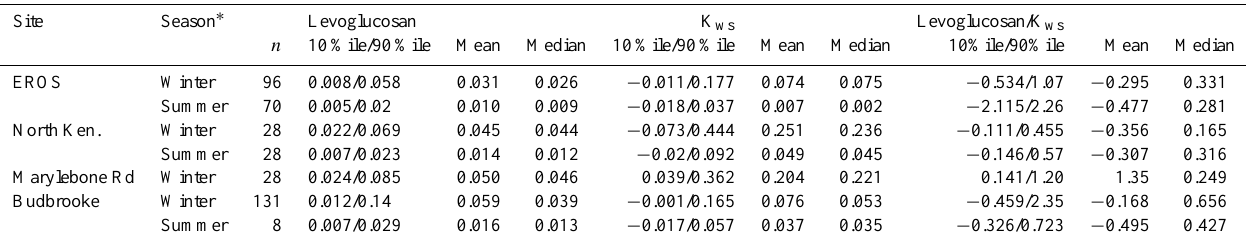
Table 1. Summary of levoglucosan and potassium (K ws ) data (µgm − 3 ) and levoglucosan/K ws ratios. Site